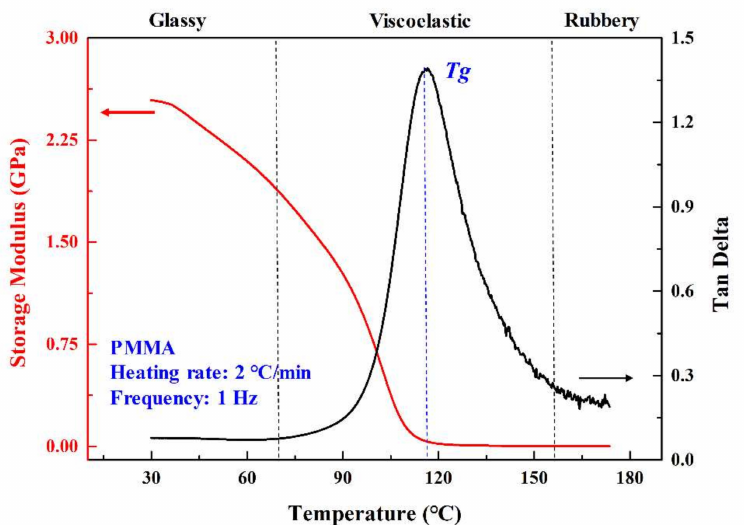
Figure 2. Dynamic properties (modulus and tan delta) vary with temperature (Sample: PMMA,